Question: Provide a one-line summary of what is displayed.
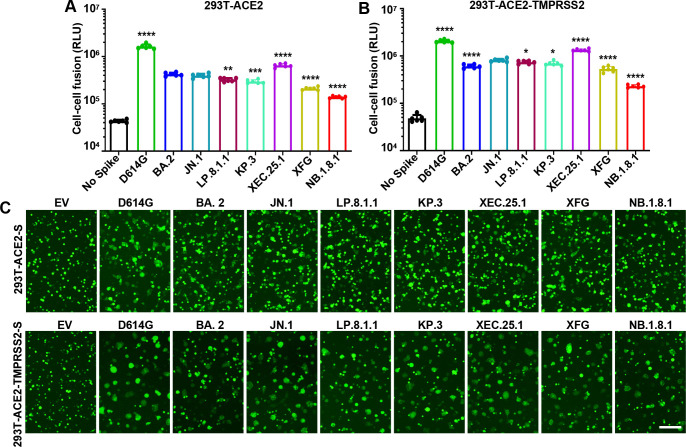
Answer: Fusogenicity mediated by SARS-CoV-2 variant spikes in 293T-ACE2 or 293T-ACE2-TMPRSS2 cells. ( A and B ) Cell–cell fusion mediated by SARS-CoV-2 variant spike proteins in 293T-ACE2 (A) or 293T-ACE2-TMPRSS2 (B) cells were determined using a T7 polymerase reporter system. All statistical analyses were conducted in comparison to the JN.1 variant. The experiments were performed with six technical replicates and repeated at least twice. Data from one representative experiment were presented as the mean ± SD. Statistical significance was determined by two-tailed Student’s t -tests, with significance indicated by * P < 0.05, ** P < 0.01, *** P < 0.001, and **** P < 0.0001. EV represents the empty vector. ( C ) Representative images of cell fusion activity induced by ACE2 and SARS-CoV-2 variant spikes (scale bar = 400 µm).